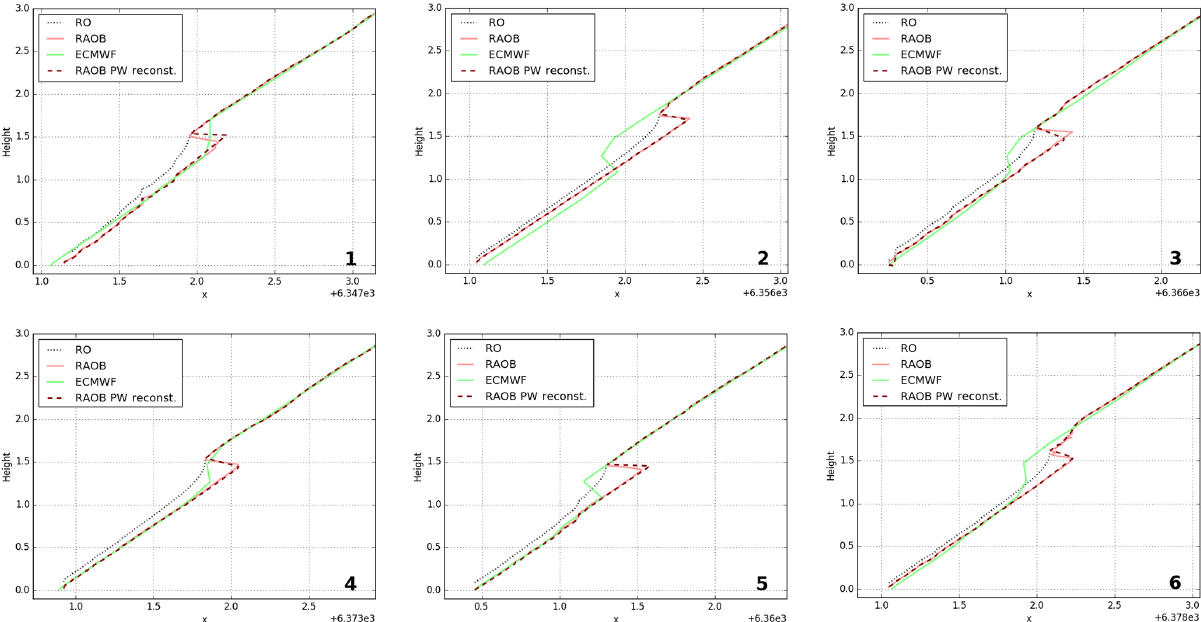
Figure 4. The x – h relationship of simulated RO, radiosonde measurements, ECMWF analysis, and reconstruction using RAOB and ECMWF-computed PW for the six collocated cases. The case numbers are shown in the lower-right corner of each panel. As shown in the figures the RO simulations maintain a one-to-one relationship between x and height when ducting happens, which causes negative bias compared to the RAOB results. The proposed method can reconstruct the bilinear shape inside the trapping layer and correct the N -bias